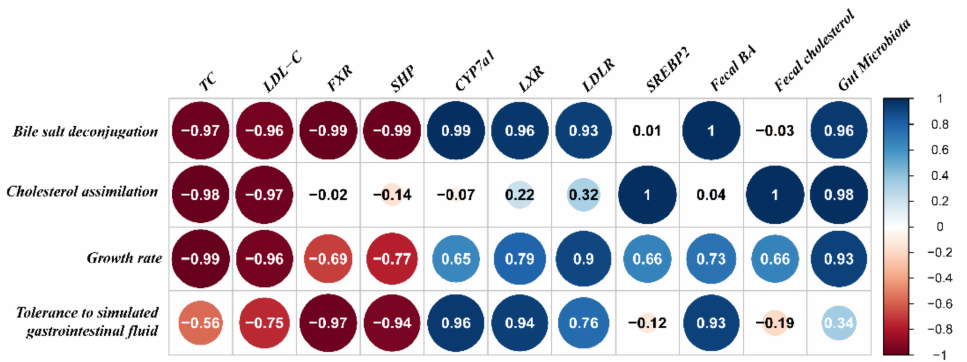
Figure 8. The correlation between the hypercholesterolemia-alleviation effects of B. longum strains and their properties in